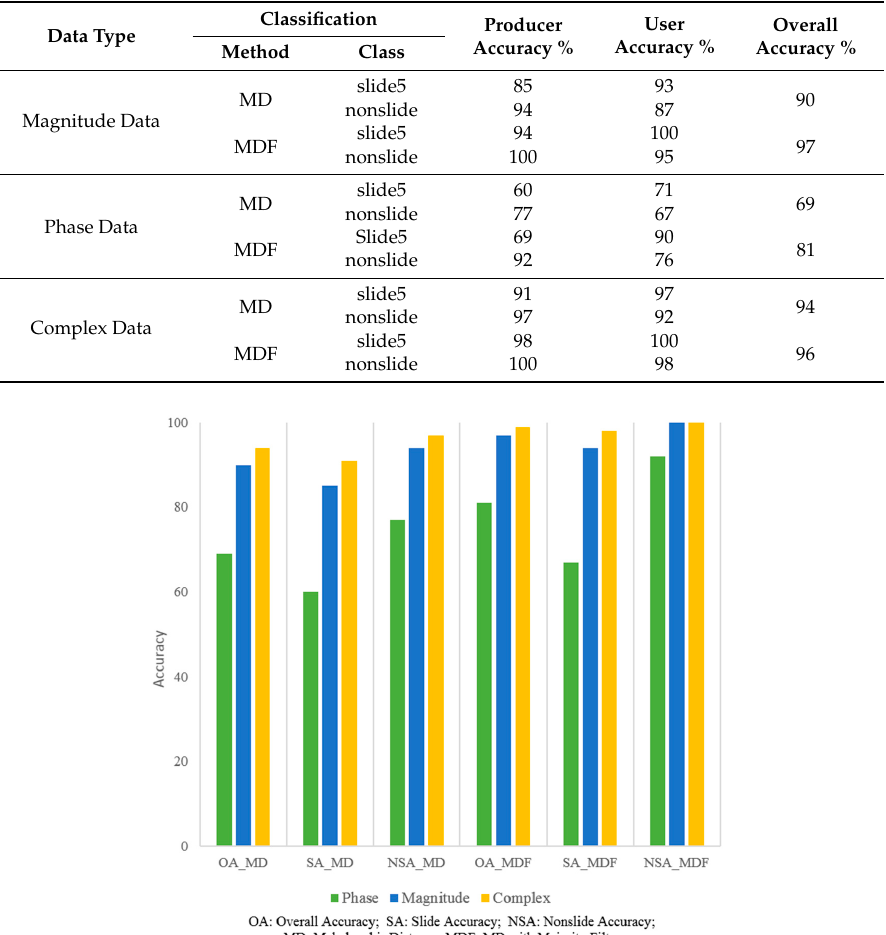
Figure 14. Accuracy comparison of the Mahalanobis distance (MD) classification and with majority filter (MDF), of the segment Sample 3, for the phase, magnitude, and complex data.